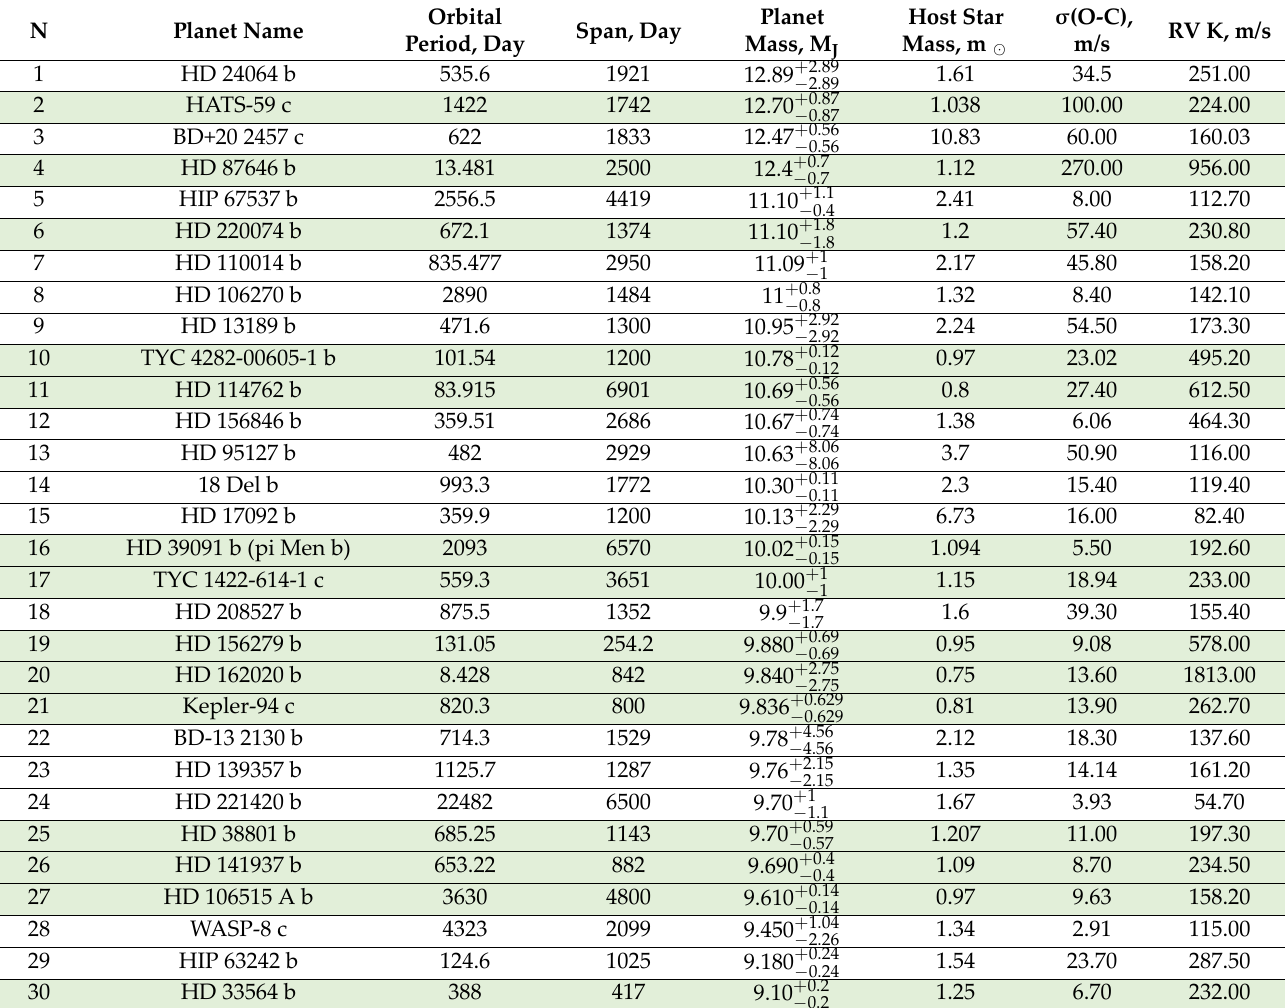
Table A2. List of considered RV planets (shading at FGK stars).